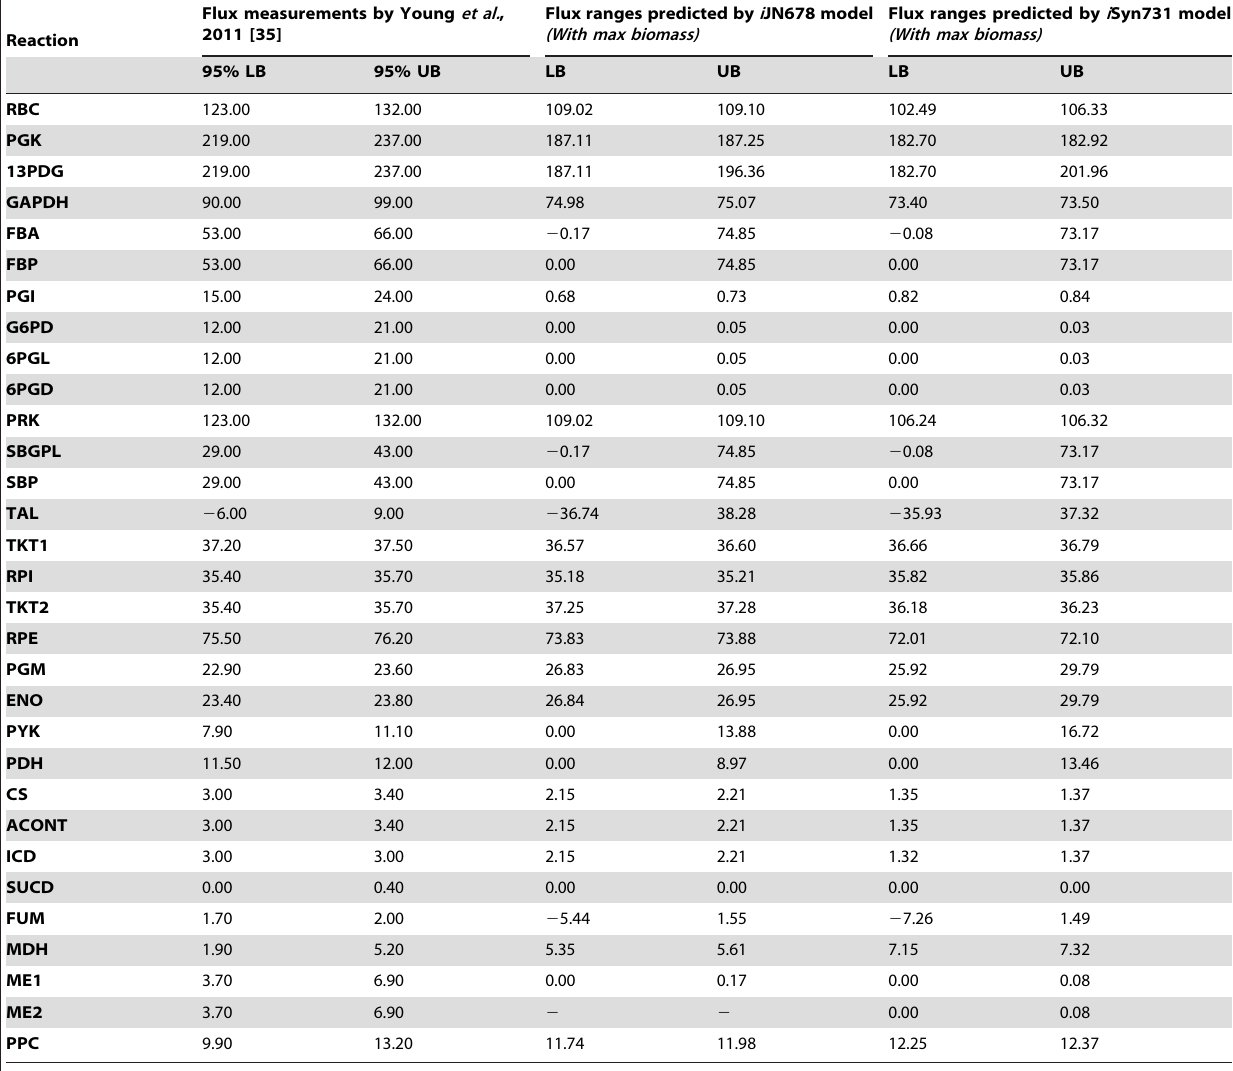
Flux ranges predicted by i JN678 model (Withmaxbiomass)